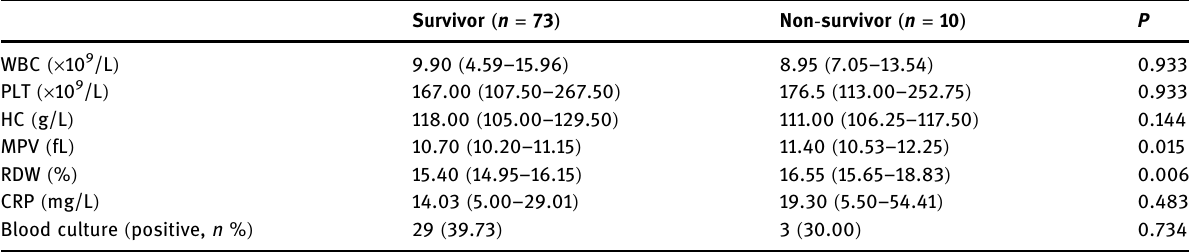
Blood culture ( positive, n % ) 29 ( 39.73 ) 0.734 WBC, white blood cell; PLT, platelets; HC, hemoglobin concentration; MPV, mean platelet volume; RDW, red blood cell distribution